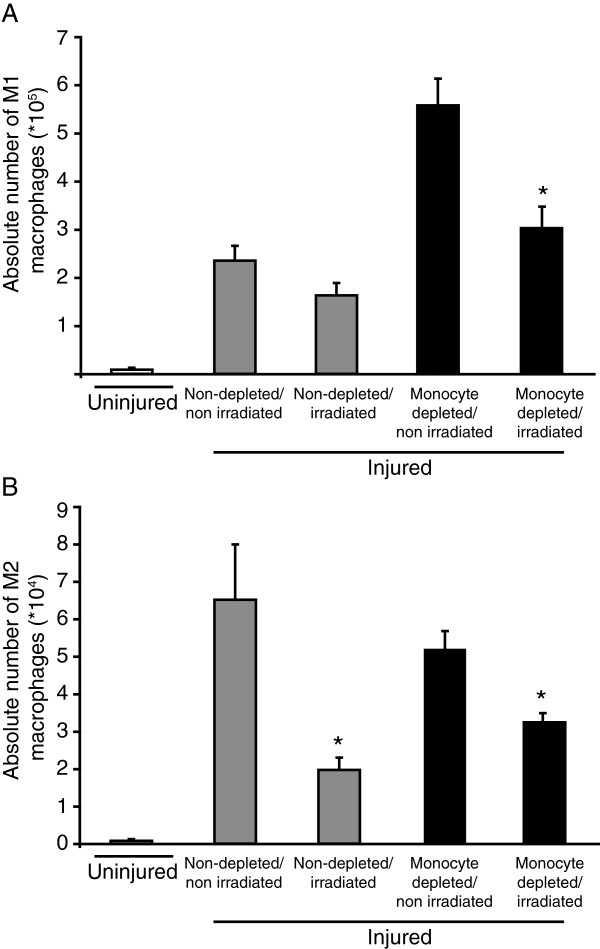
Irradiation modulates M1 and M2 macrophage accumulation in TA muscle. Hind limb was submitted to 20 Gy 24 h before injury to inhibit proliferation of resident cells. Rats were treated, or not, with daily intravenous injection of liposome-encapsulated clodronate starting 24 h prior to injury until euthanasia at 4 d post-injury, for analysis of the numbers of M1 and M2 macrophages into injured muscle. (A) Irradiation significantly decreased M1 macrophage accumulation when monocytes were depleted. (B) Irradiation impaired the accumulation of M2 macrophages following depletion or not. *Significantly different from the non-irradiated condition homologous, Student’s t-test, p < 0.05. n = at least 3, for all the time points and conditions evaluated.